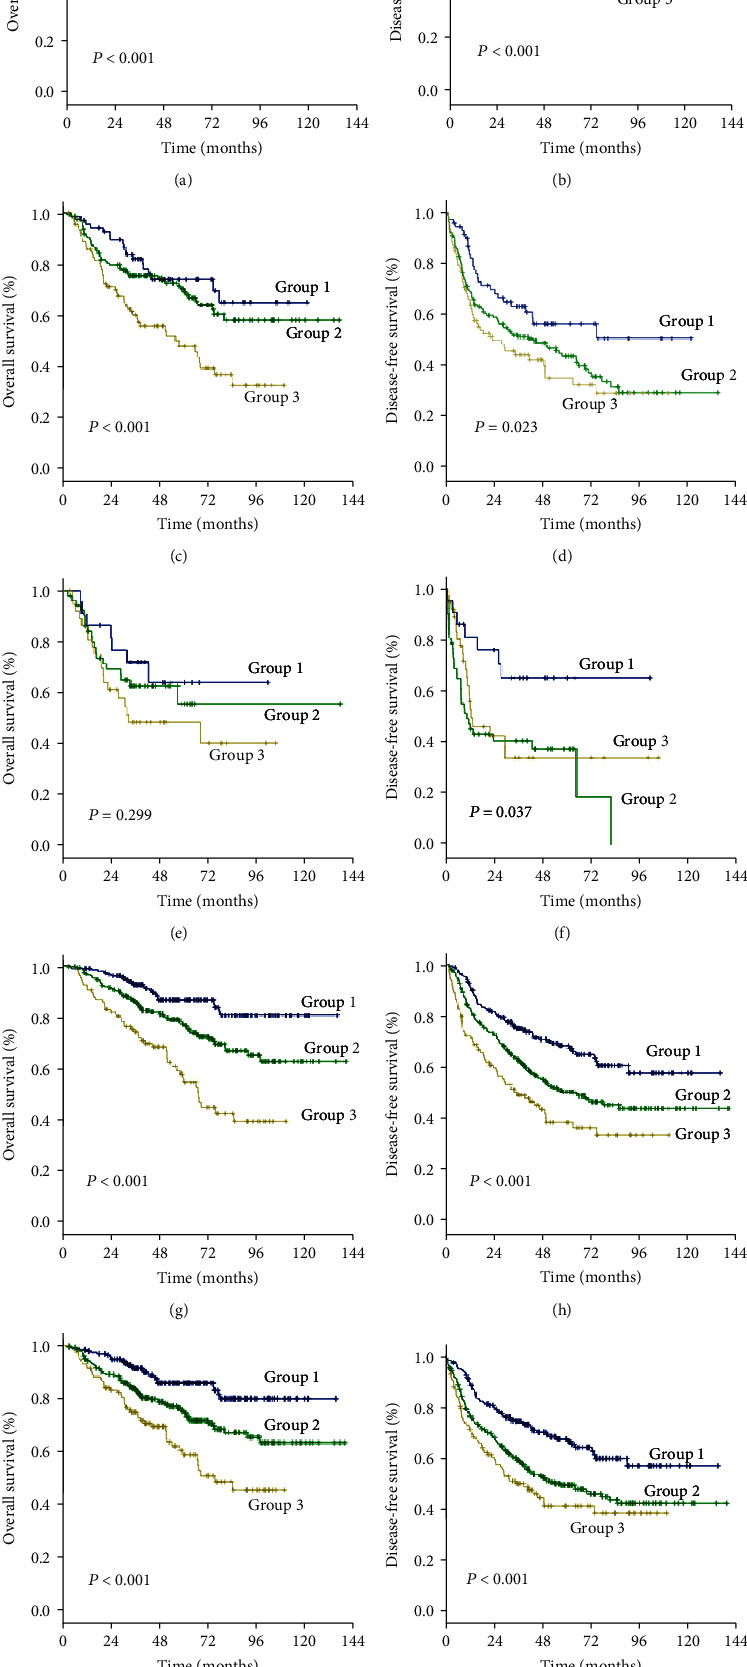
Subgroup analyses based on the Milan criteria and MVI. Group 1 was defined as GGT < 37.2 U/L; group 2: GGT ≥ 37.2 and <102.8 U/L; group 3: GGT ≥ 102.8 U/L. The overall survival (a) and disease-free survival (b) curves of patients meeting the Milan criteria. The overall survival (c) and disease-free survival (d) curves of patients exceeding the Milan criteria. The overall survival (e) and disease-free (f) curves of patients with microvascular invasion. The overall survival (g) and disease-free survival (h) curves of patients without microvascular invasion. The overall survival (i) and the disease-free survival (j) curves of patients classified as BCLC grade A.